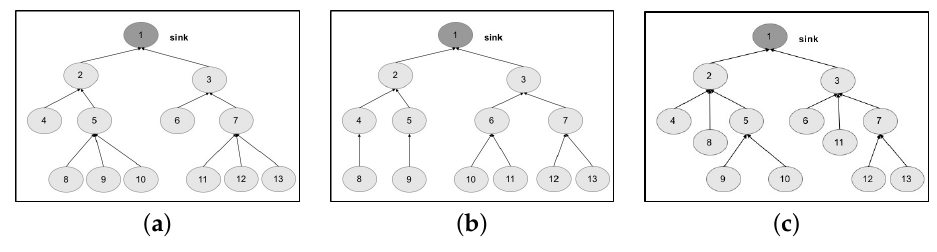
Figure 10. Topologies of the self-powered WSN. ( a ) Original; ( b ) First attempt; ( c ) Second